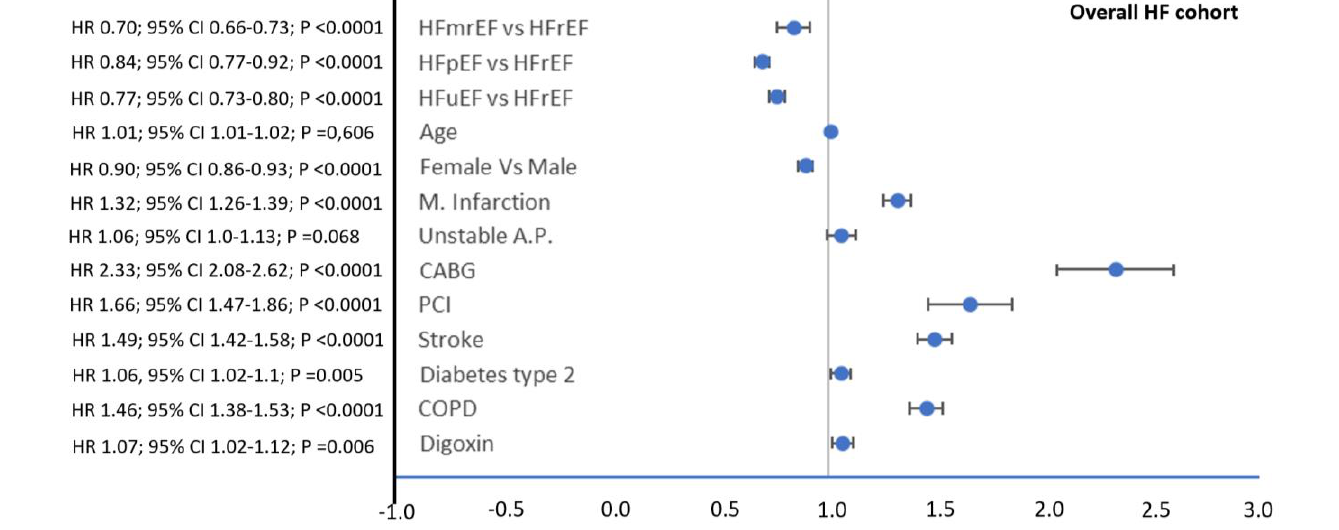
Figure 2. Cox regression analysis for associations between specific patient characteristics and the risk of the composite outcome of HF hospitalization and all-cause mortality (time to first event, either HF hospitalization or all-cause death) in the overall HF cohort. Abbreviations: CABG = coronary artery bypass graft; COPD = chronic obstructive pulmonary disease; HF = heart failure; HFmrEF = heart failure with a mildly reduced ejection fraction; HFpEF = heart failure with a preserved ejection fraction; HFrEF = heart failure with a reduced ejection fraction; HFuEF = heart failure with an unknown ejection fraction; M. Infarction = myocardial infarction; PCI = percutaneous intervention; Unstable A.P. = unstable angina